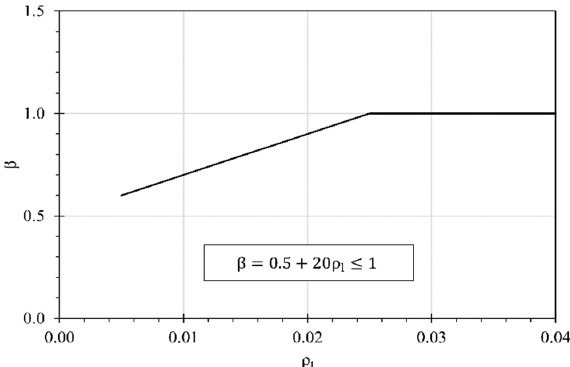
Figure 8. The factor β after Kowalsky and Priestley [30] (in Equation (14)).